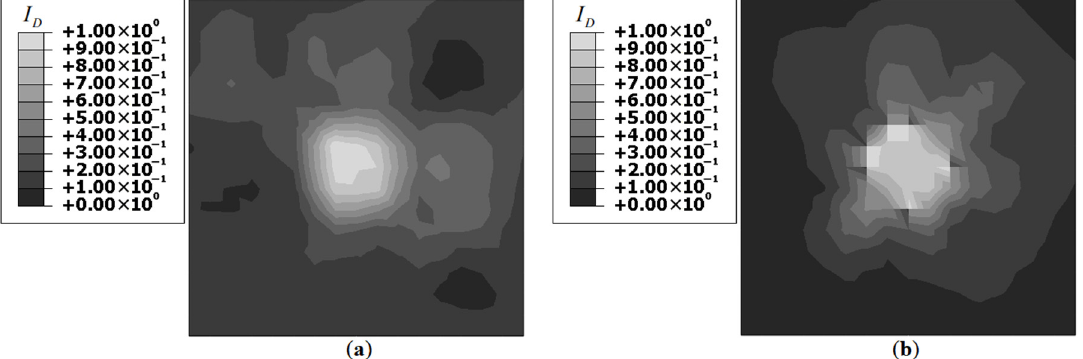
Figure 19. iFEM reconstructed I D distribution for Damage Case-3 using: ( a ) Unitcell-1, and ( b ) Unitcell-2.